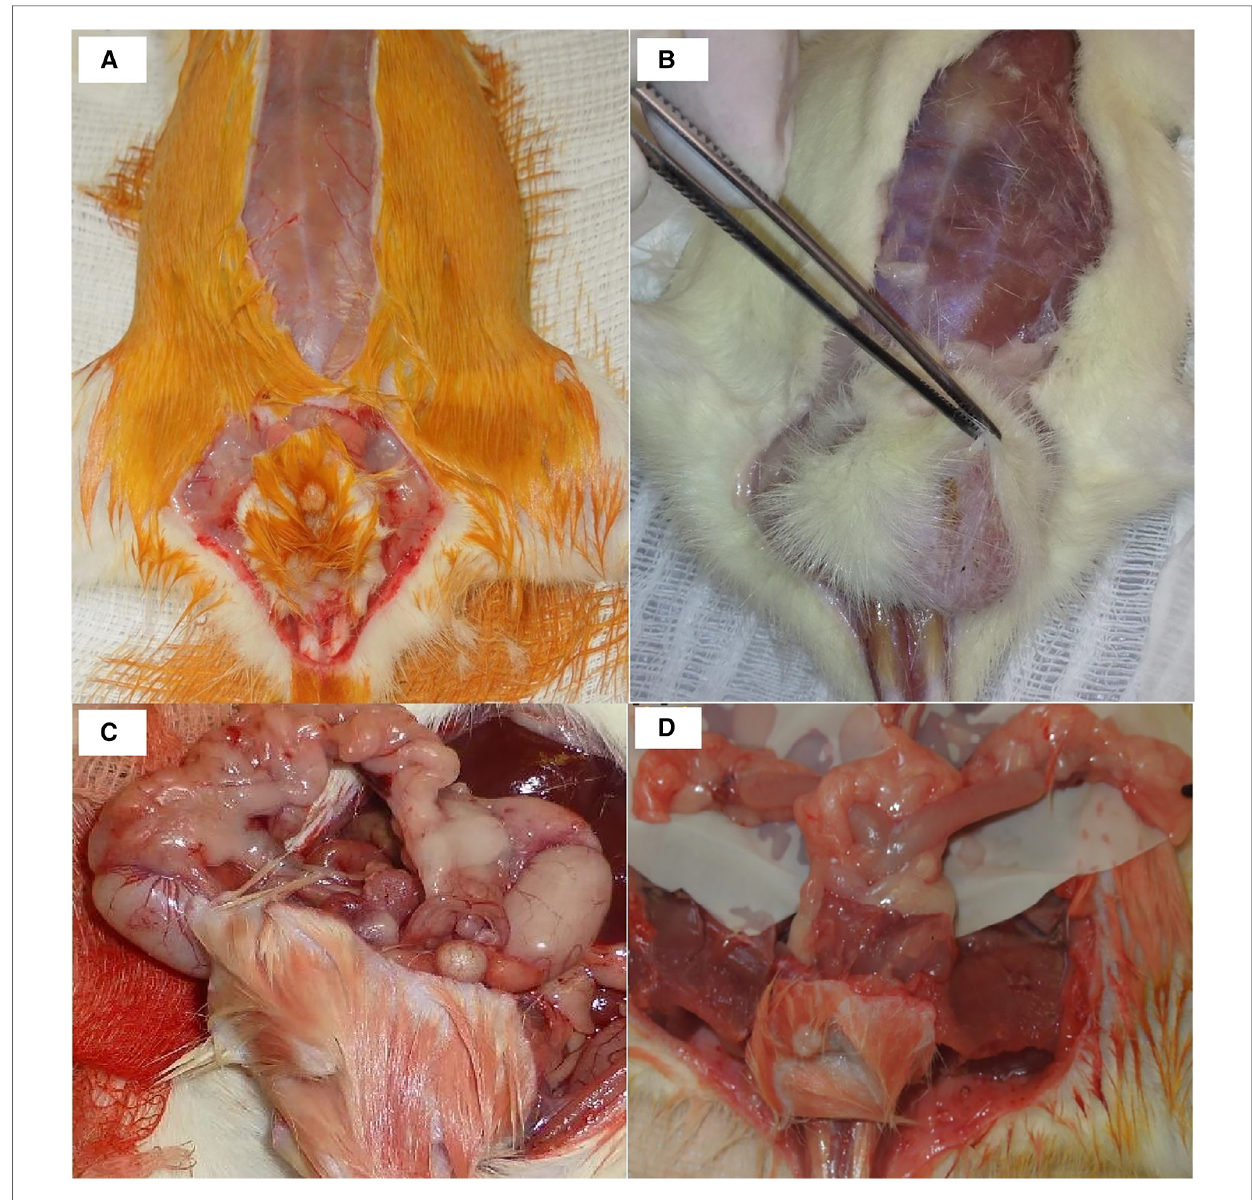
FIGURE 1 Incision details in male ( A ) and female ( B ) donors. Graft dissection in male ( C ) and female ( D )